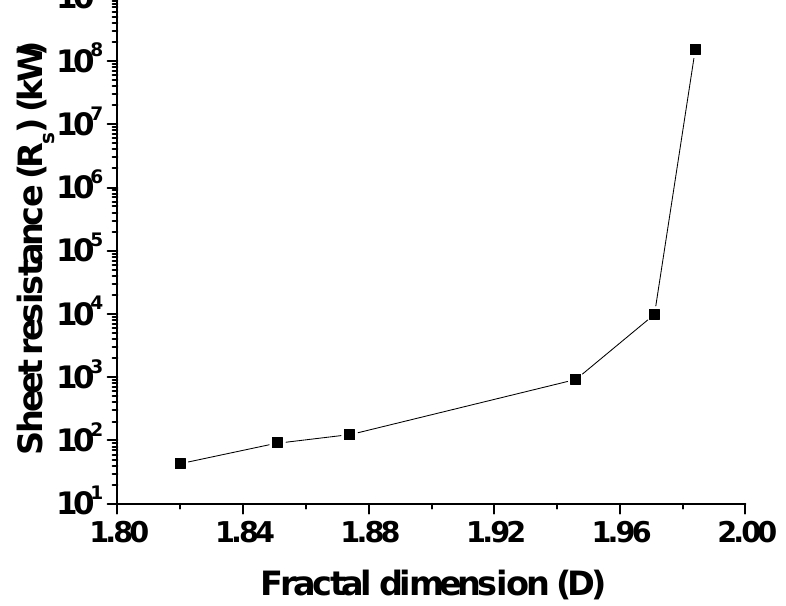
Figure 10. Variation in sheet resistance with fractal dimension of a given CNT network. The fractal dimension is inversely proportional to the MWCNT concentration in the